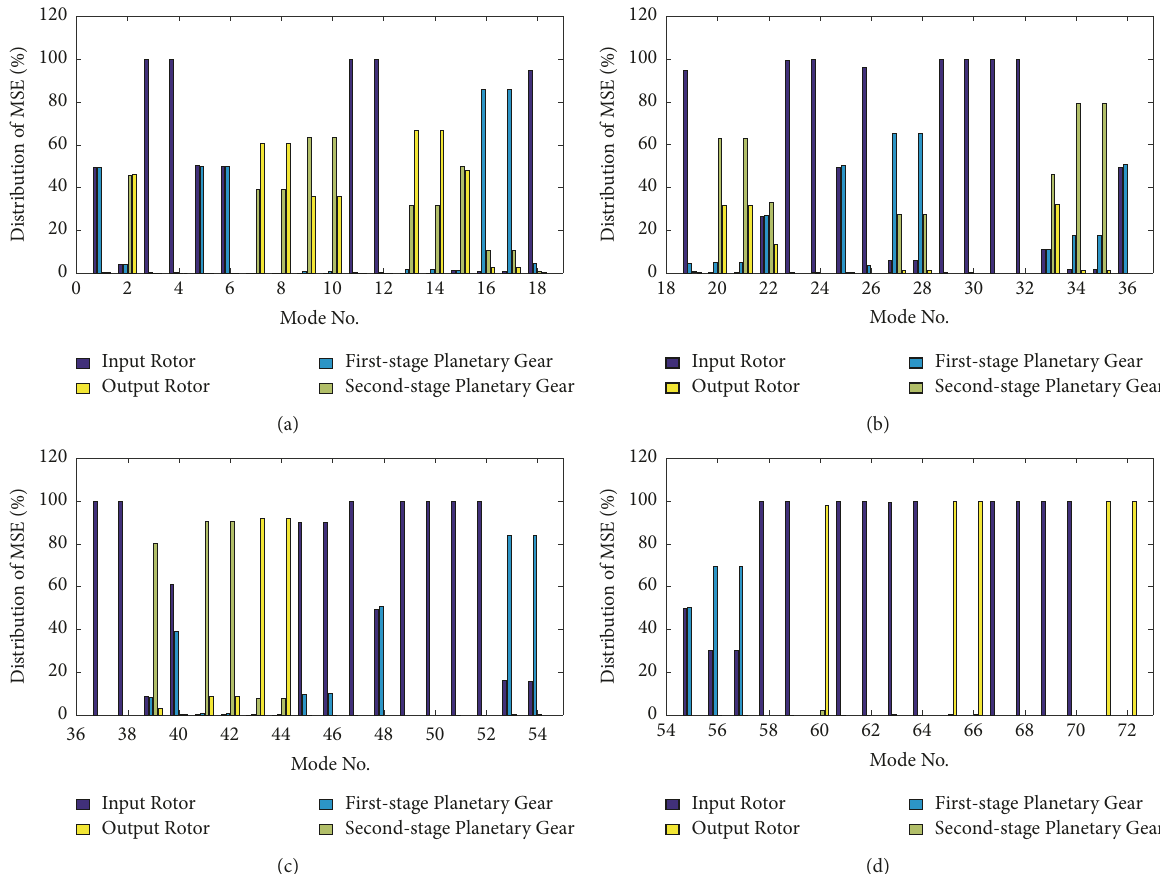
Figure 8: MSE distribution of each mode associated with each subsystem: (a) the first 18 modes, (b) the 19 th ∼36 th modes, (b) the 37 th ∼54 th modes, and (b) the 55 th ∼72 nd